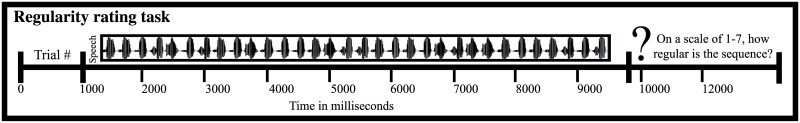
Experimental design.The trial number was displayed for 1000 ms and was followed by the an auditory sequence which lasted for 8800 ms. A question mark then appeared triggering participants to determine sequence regularity on a scale of 1 to 7.